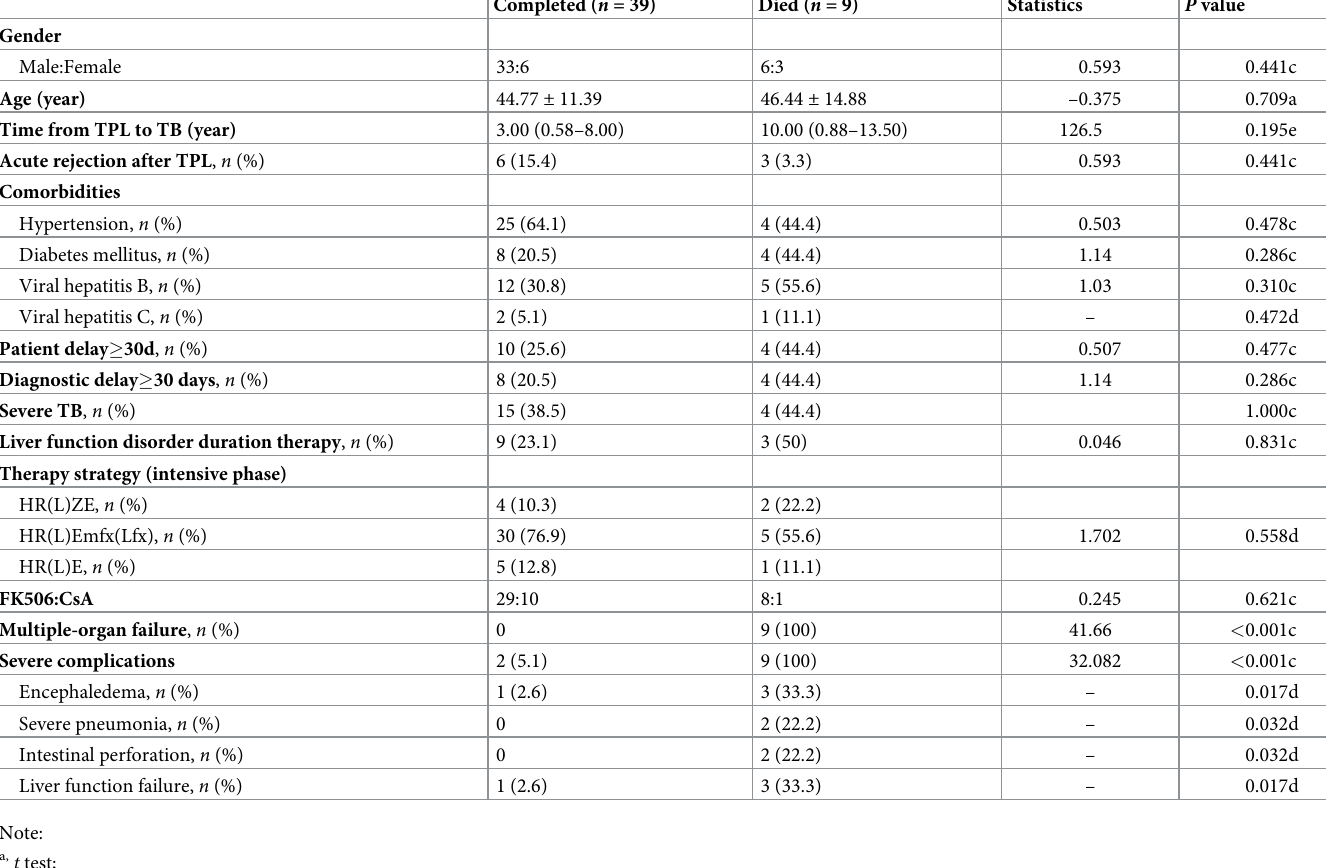
Table 4. Risk factors for death during anti-tuberculosis